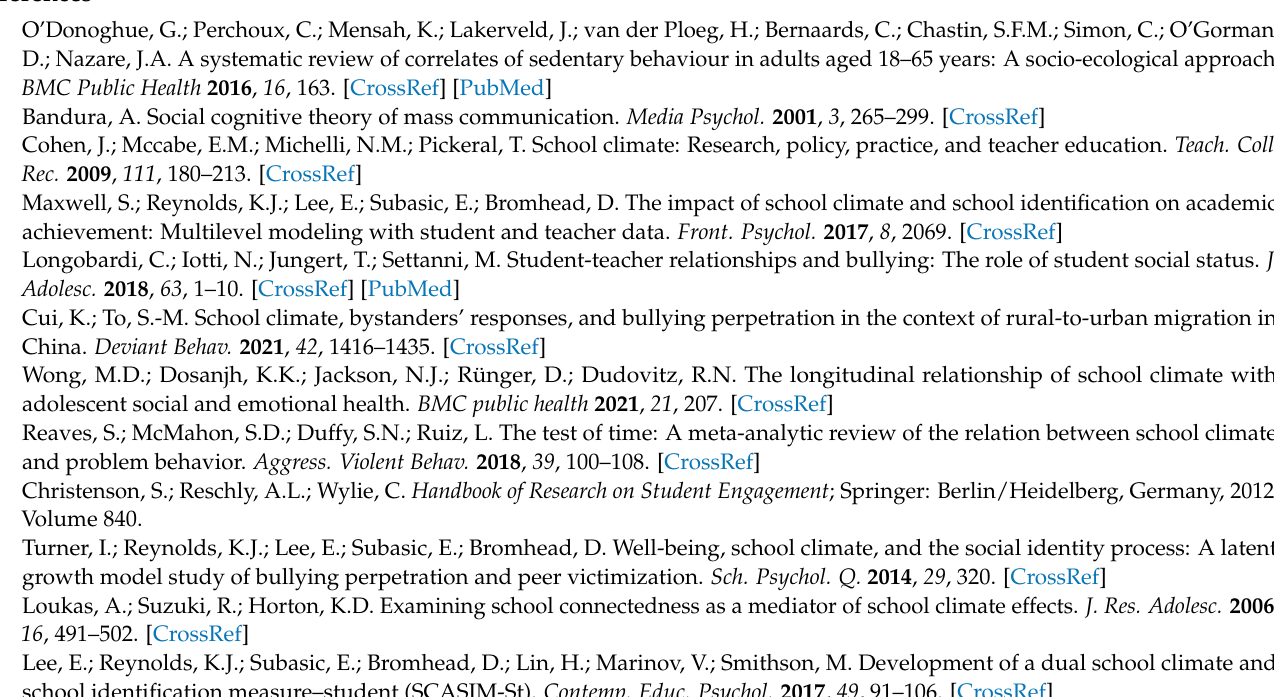
Table S2: Correlation matrix among the factors of